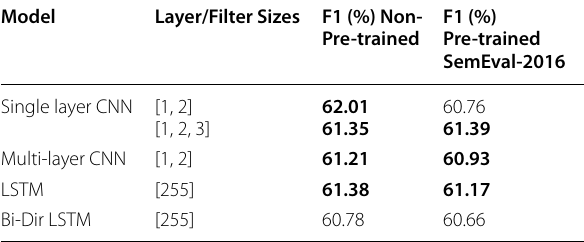
Bold values indicates the top-performing models